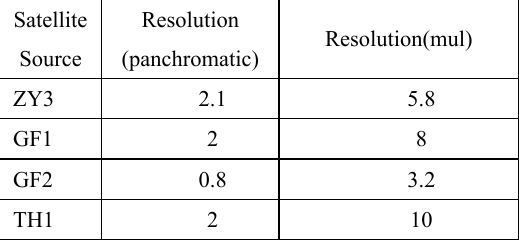
Table 1. Satellite images ground resolution